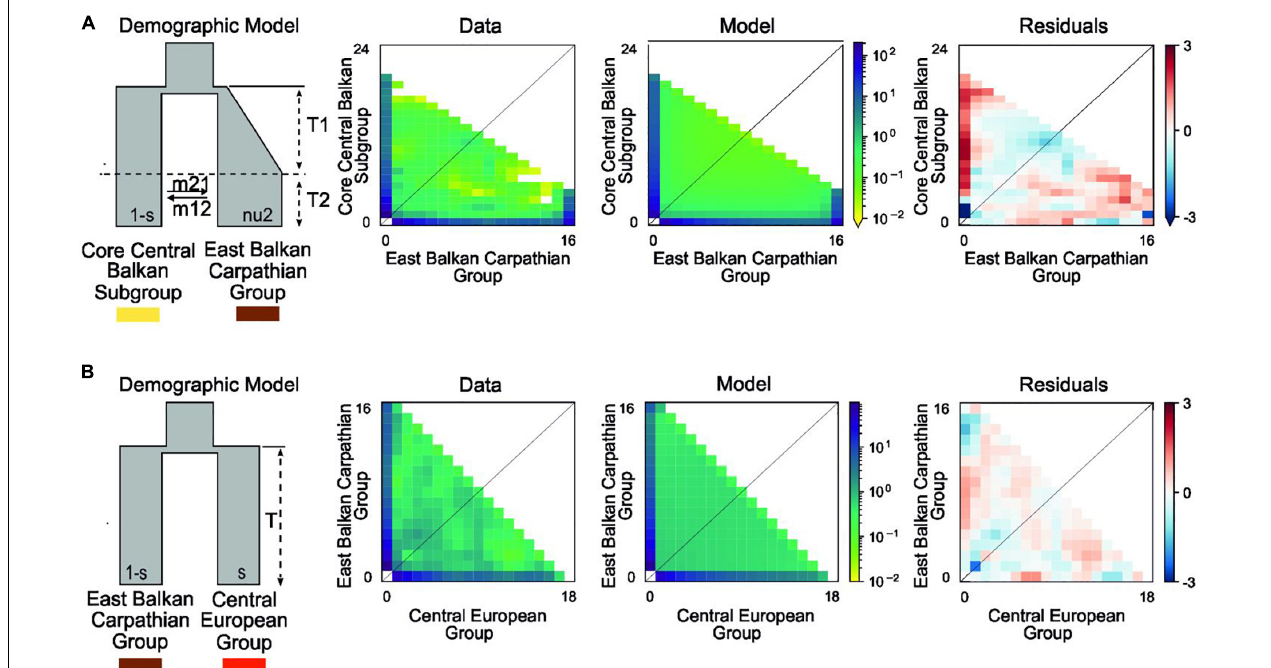
FIGURE 3 | Best-fitting demographic models for various phylogeographic groups of Aurinia saxatilis using a two-dimensional joint site frequency spectrum (2D-JSFS) between population sets including (A) the Core Central Balkan Subgroup ( n = 24) and the East Balkan-Carpathian Group ( n = 16) and (B) the East Balkan-Carpathian Group ( n = 16) and the Central European Group ( n = 18). A visual representation of the best-fit model is depicted, along with comparisons of the 2D-JSFS for data, model, and resulting residuals. For both comparisons, the best-fit model represents the scenario where the split is theoretically pre-glacial